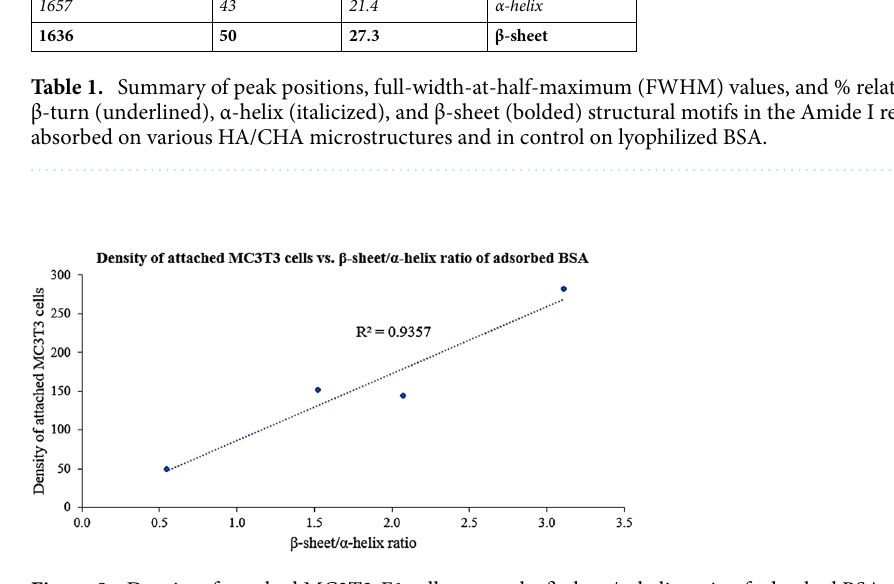
Figure 8. Density of attached MC3T3-E1 cells versus the β-sheet/α-helix ratio of adsorbed